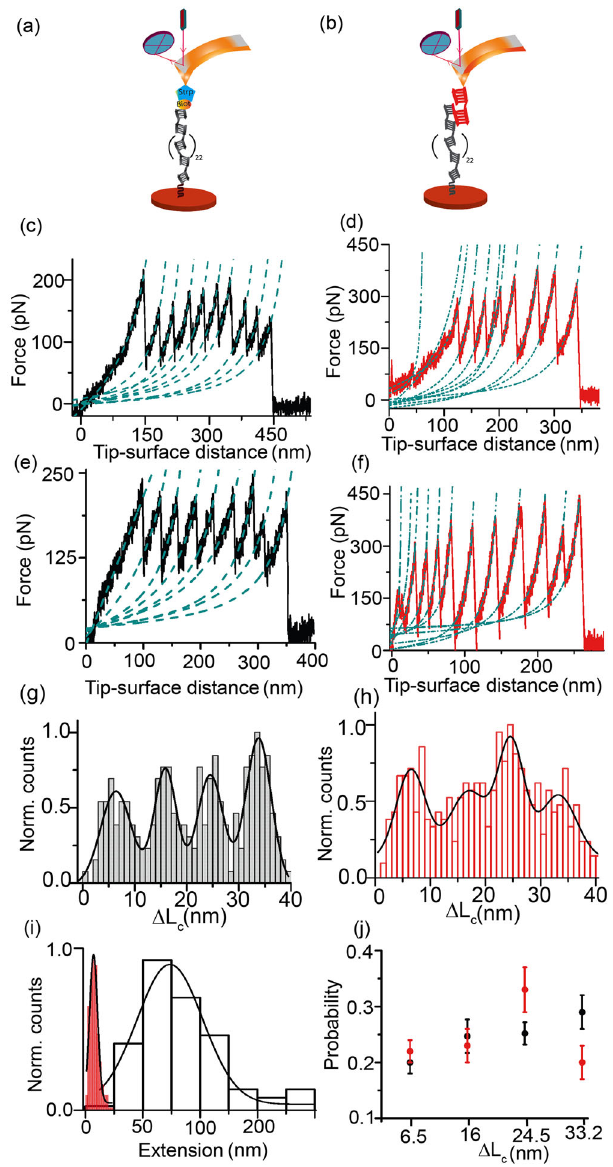
Fig. 1 Distinct unfolding propensity of Cdh23 in HAP and PAP con fi gurations. a Schematic representation of HAP of Cdh23 using AFM where the C-terminus of Cdh23 is covalently attached to glass coverslip using sortagging. The N-terminal of Cdh23 is recombinantly modi fi ed with biotin and pulled by streptavidin-coated cantilevers. b Scheme of PAP con fi guration depicting the partner-assisted pulling of Cdh23 EC1-27 with Pcdh15 EC1-2 (red). c and e Representative force-extension curves of Cdh23 in HAP (black) at 2000nm s − 1 and 3000 nm s − 1 pulling speeds, respectively. Both curves depict an initial long stretch followed by sawtooth patterns. d and f Representative force-extension features of Cdh23 in PAP (red) at 2000 nm s − 1 and 3000 nm s − 1 pulling speeds respectively. Both curves exhibit multiple unfolding peaks at the initial stretches, followed by sawtooth patterns of unfolding. The dotted green lines in ( c – f ) are the WLC model fi t. g and h Distributions of Δ L c of Cdh23-stretching in HAP (black line) ( n = 838 unfolding events) and PAP (red) ( n = 946 unfolding events), respectively. The data are combined for all loading rates. Solid lines represent the Gaussian fi ts exhibiting four unfolding peaks. i Distributions of initial long and short stretches of Cdh23 obtained in HAP (black) and PAP (red), respectively. The data are plotted for all the force curves obtained at different pulling velocities. Gaussian fi ttings of the histograms (solid black line) exhibit a mean length gain of 75.0 ± 2.2 nm in HAP and 6.5 ± 0.3 nm in PAP. Errors mentioned are the standard error of fi tting. j Probability distributions of four different stretches of Cdh23 in HAP (black) and PAP